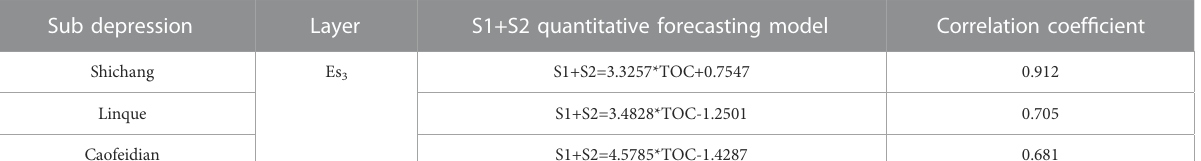
TABLE 2 Prediction model of hydrocarbon generation potential of Es 3 source rocks of Nanpu Sag.